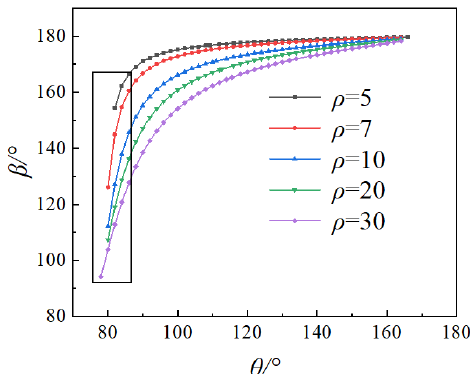
Figure 7. The curves of different ρ at λ = 0.2.